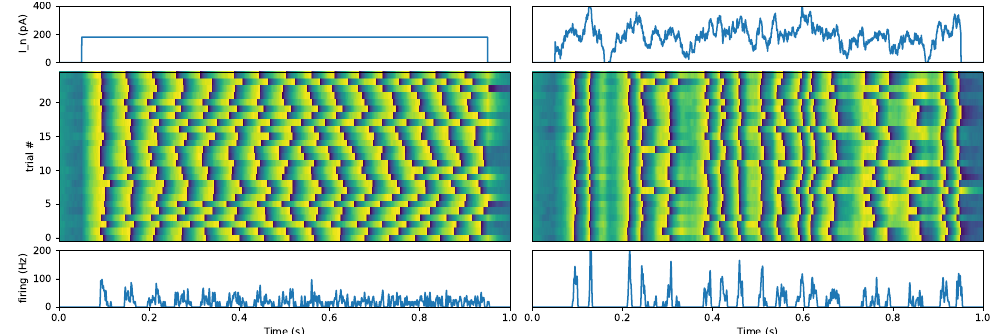
Figure 2. Reproducibility of the spiking response of a neuron. The timing of the spikes produced following the repetition of a step stimulus is less reproducible than that to a noisy stimulus. The stimulus current value over time for a step stimulus (top left) and for a noisy one (top right). Trial repetitions of a leaky integrate-and-fire neuron stimulated by the stimulus on the upper row (middle row). Membrane potential is represented by dark blue color when light yellow colors when depolarized) and quantified by the average firing rate across trials (lower row). While this seems paradoxical at first sight, it highlights the consequence of using the same frozen noise at each repetition and highlights the highly reproducible pattern of spikes when it is driven by a highly dynamic input. See this notebook for a replication of the results from [33] using a simple LIF model. At the level of the retina, it has been shown that a coding of luminance values in the image using the timing of the spikes may be at work [10]. In particular, these results show that the response of ganglion cells to the visual gratings projected on the retina could be encoded in the latency of the response and not only in the frequency of the